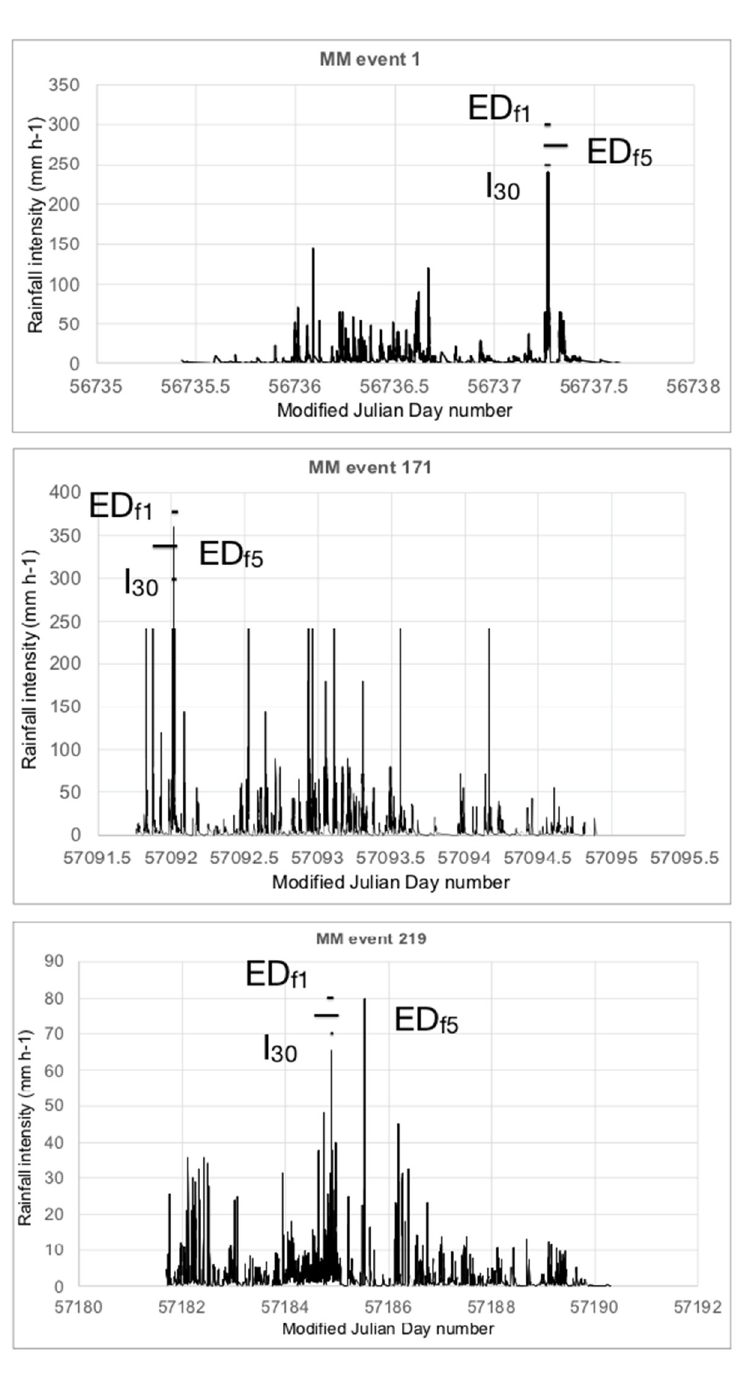
Figure 2. Position of the time intervals of I 30 , ED f1 , and ED f5 in MM rainfall events MM 1, 171, and 291. Refer to text for details.